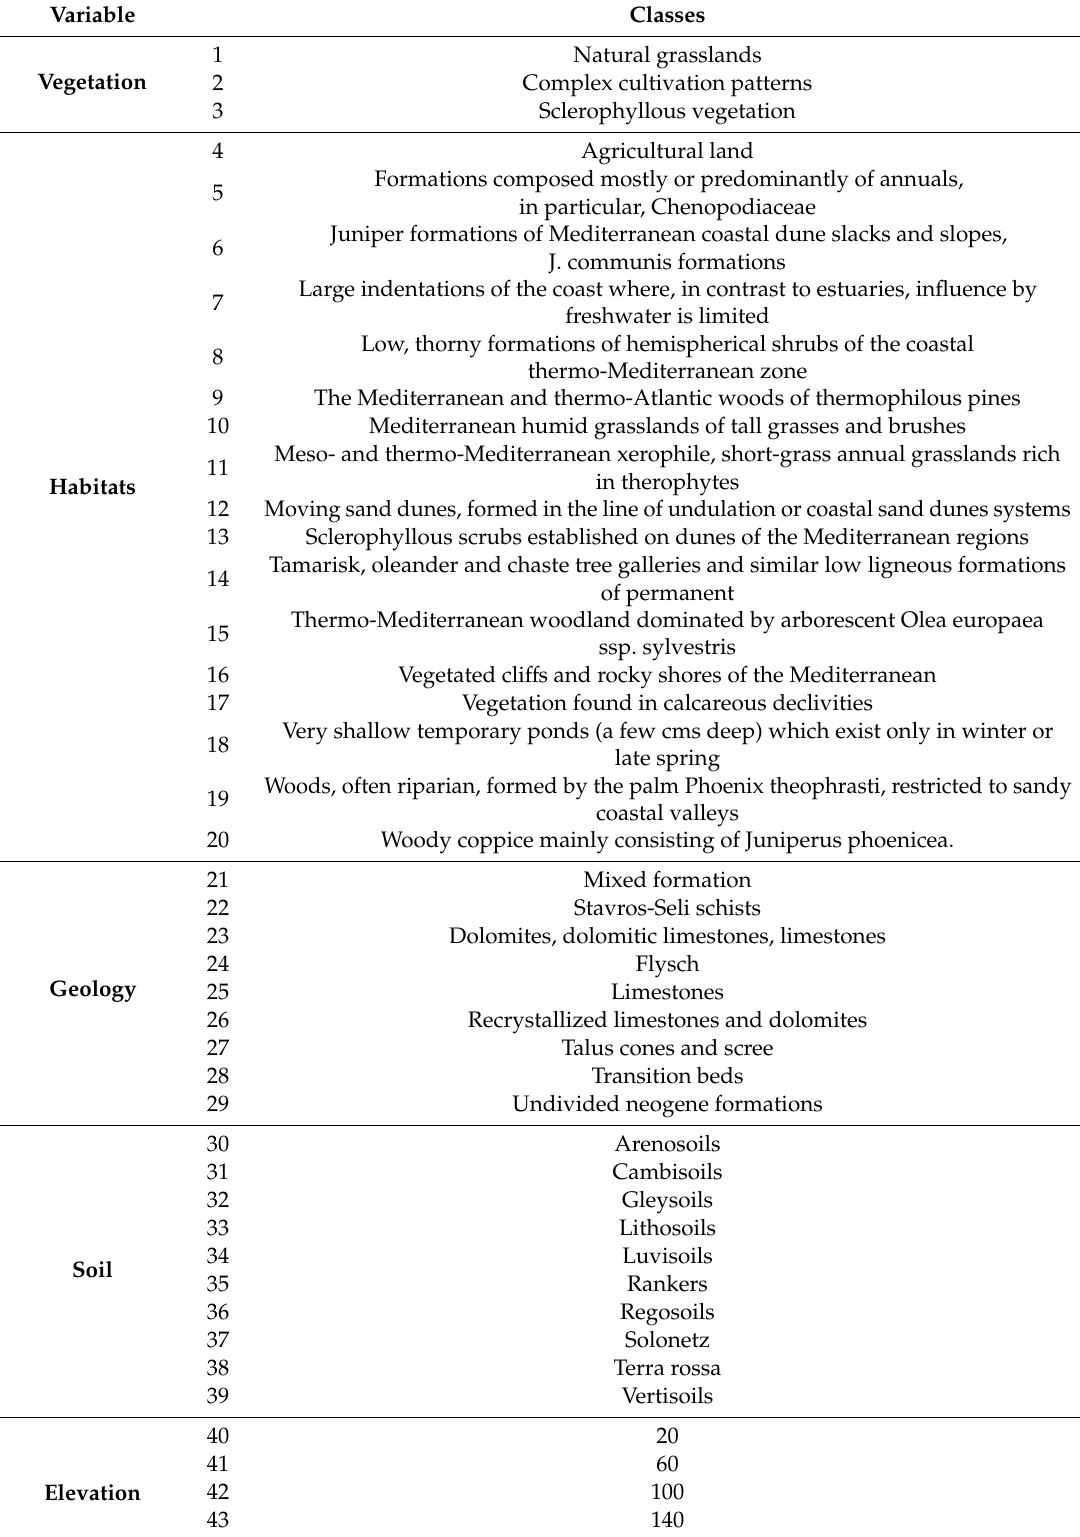
Table 1. Reclassification of the natural parameters into di ff erent